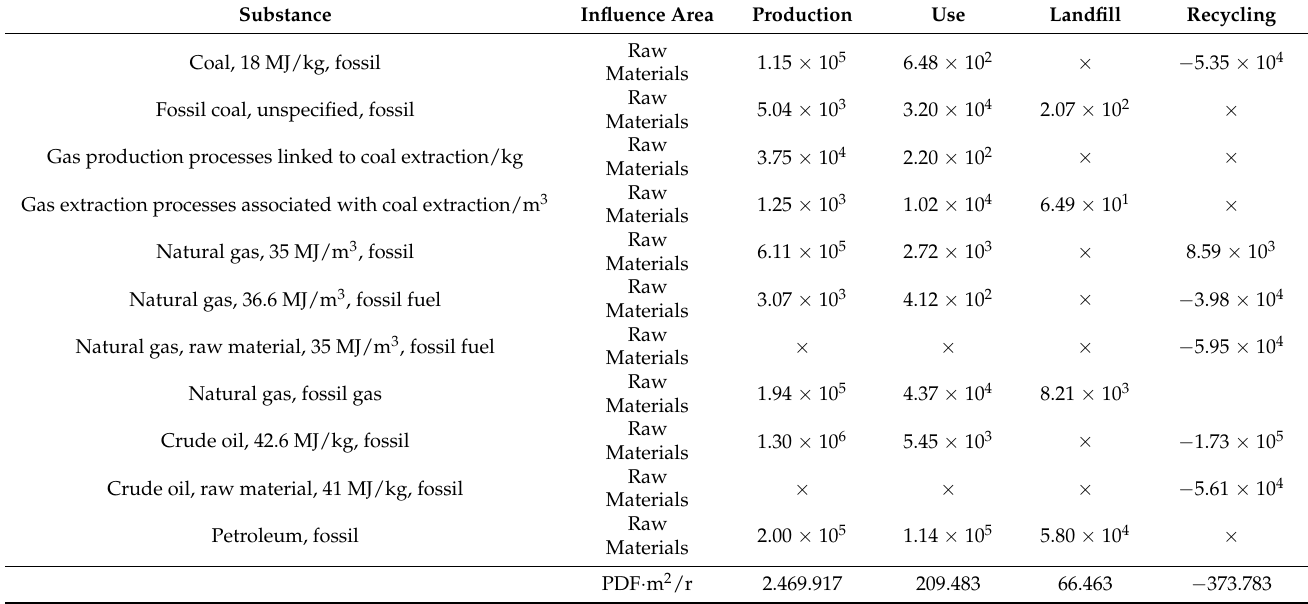
Table 10. The results of the study characterizing the environmental consequences for the processes related to the extraction of non-renewable energy, occurring at individual stages of the life cycle of the Vestas V90, MJ wind farm [own